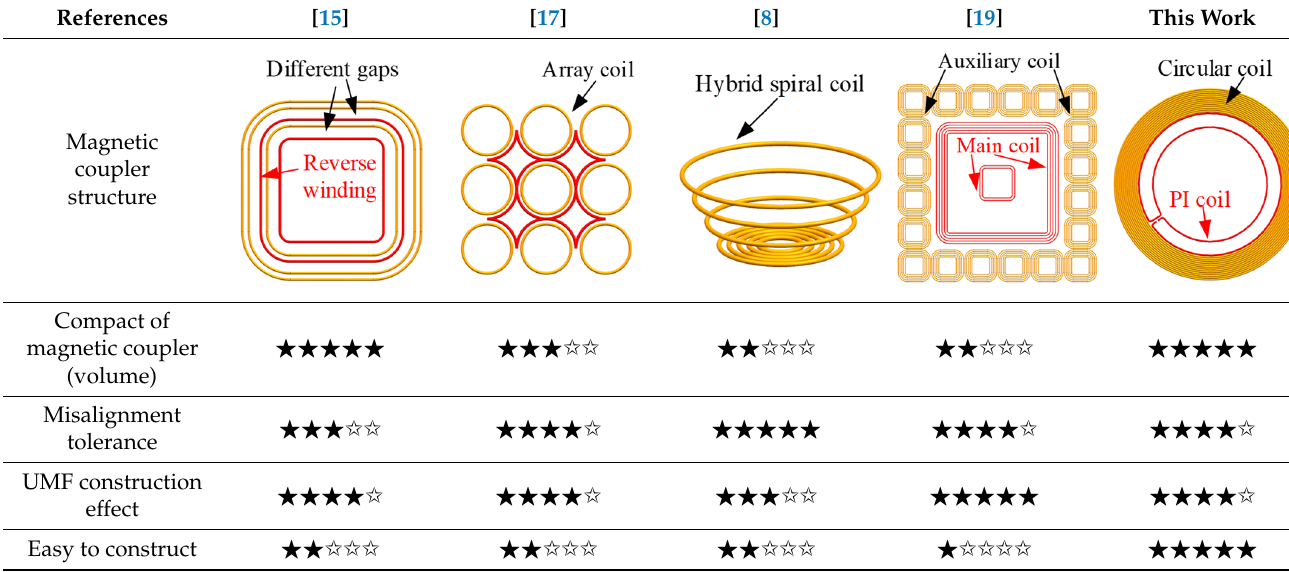
Table 1. Comparison of some UMF construction methods.